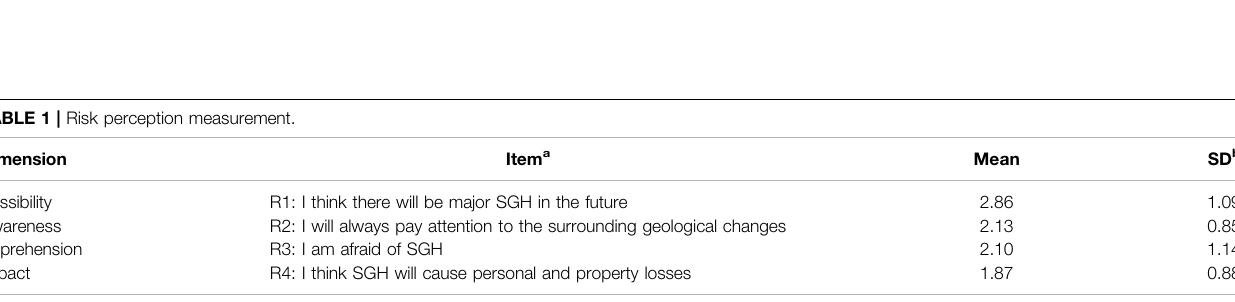
TABLE 1 | Risk perception